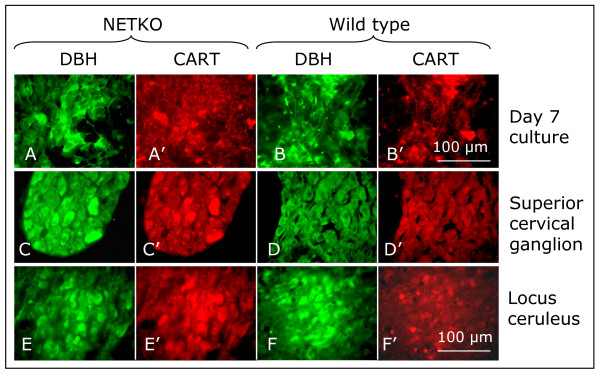
Co-localization of CART and DBH immunoreactivities in wild type and NETKO neural crest cells, superior cervical ganglion and locus ceruleus. (A, A', B, B'), NETKO and wild type neural crest cultures, respectively, at day 7. (C, C', D, D'), superior cervical ganglion of 10 week-old mice; (E, E', F, F'), Locus ceruleus from 10-week old wild type and NETKO mice. Wild type cells express CART at low levels. DBH and CART immunoreactivities co-localize in all three tissues. CART and DBH immunoreactivity appear somewhat brighter in NETKO tissue than in wild type tissues, suggesting increase in expression not only at the RNA but also at the protein level. It needs to be noted that immunofluorescence was not quantified. Bar, (A – F') 100 μm.